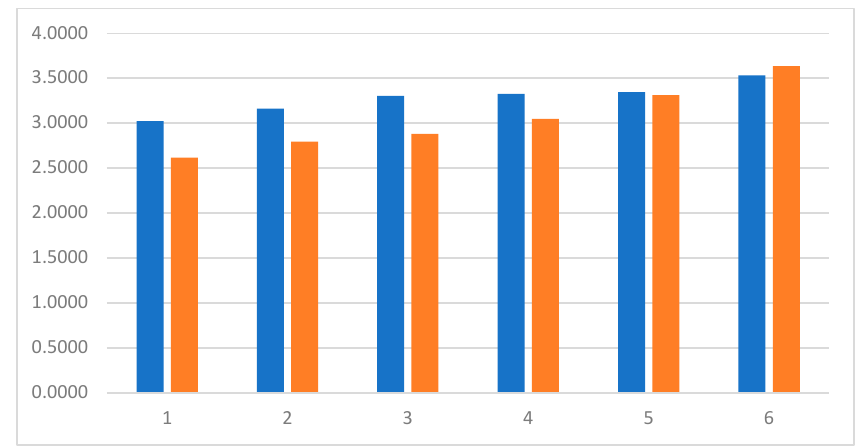
Figure 10. Difference in response between age groups.